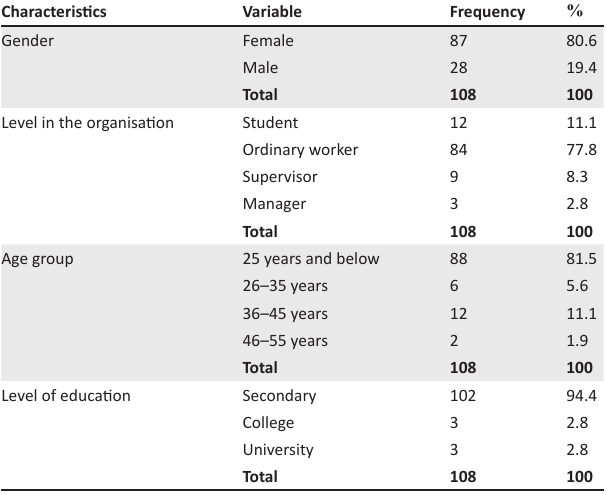
TABLE 1: Demographic characteristics of